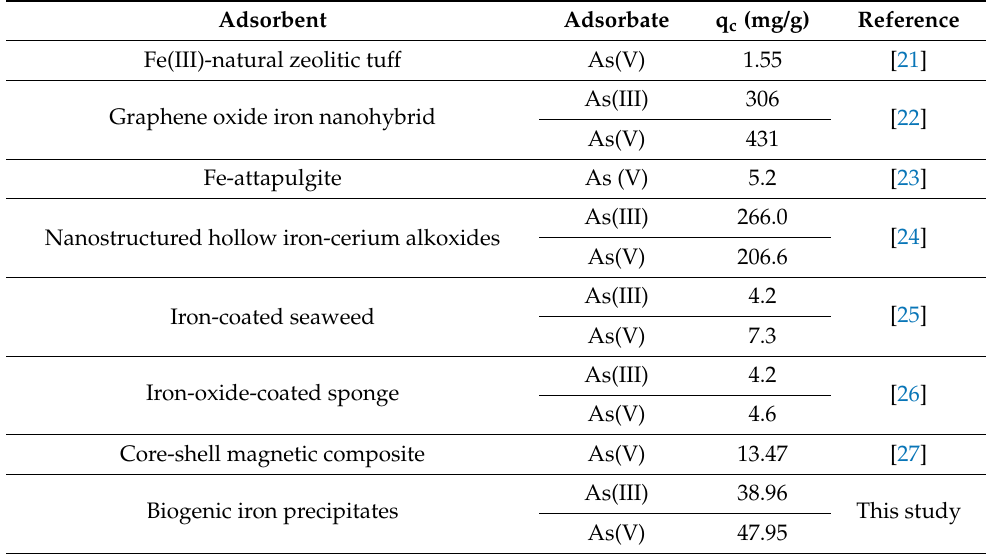
Table 3. Comparison of maximum arsenic adsorption capacities of biogenic iron precipitates with other iron-based adsorbents.